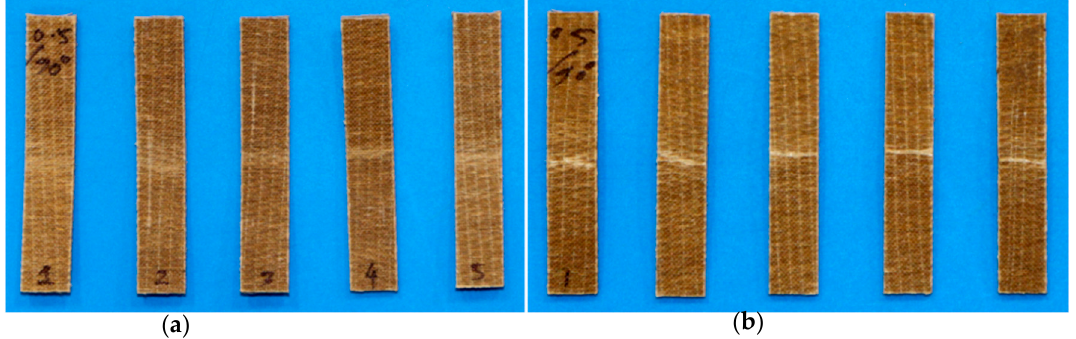
Figure 22. Flexural strength for neat PP and flax/PP samples of different fibre volume fractions and orientations.